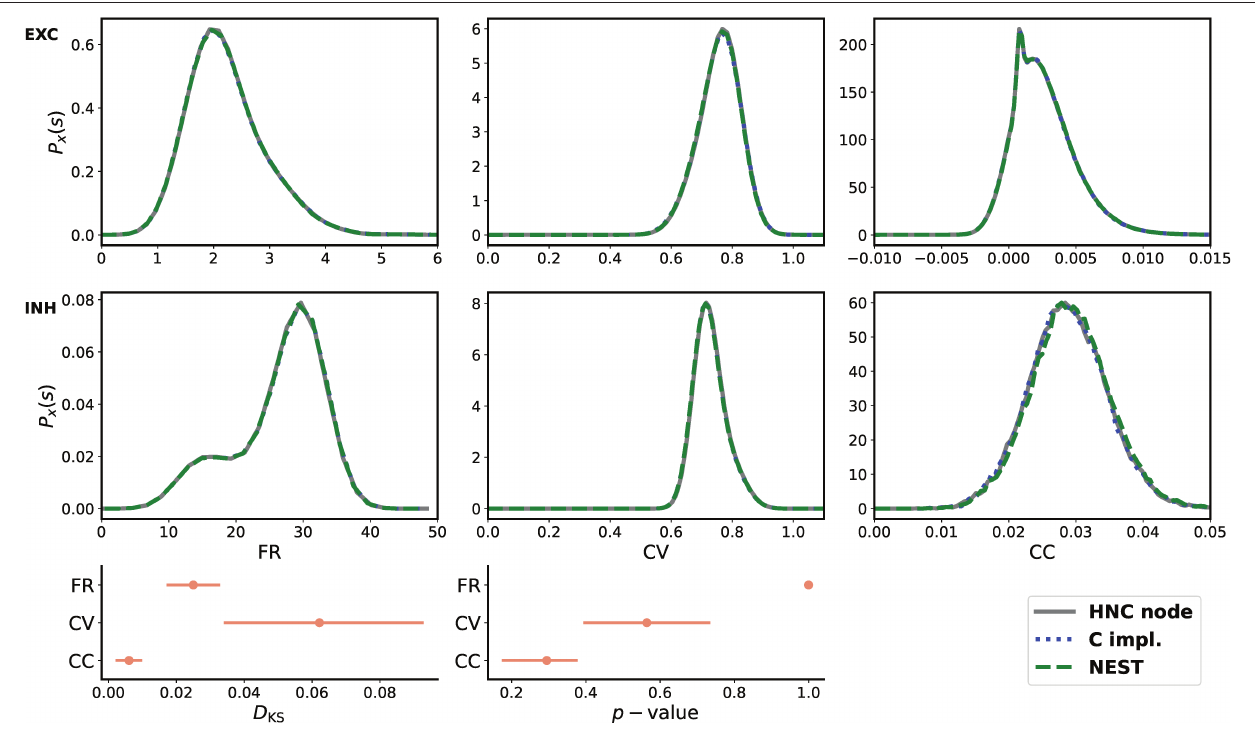
FIGURE 5 | Quantitative comparison of statistical measures. Upper two rows from left to right: probability distribution of average firing rate (FR), coefficient of variation (CV), and Pearson’s correlation coefficient (CC) for the excitatory (EXC) and the inhibitory (INH) population. The measures were calculated from 30 min simulated time. For the calculation of CC, spike trains were binned at 2 ms. In order to derive the probability distributions from the calculated measures, the Freedman-Diaconis rule was applied to select the width of the bins of the distribution histograms, and a Gaussian kernel was used for density smoothing. The bottom row shows the Kolmogorov-Smirnov statistics calculated from the raw samples of the calculated statistical measures. During the simulations performed on the HNC node, using the NEST simulator, and carried out using the reference C implementation, the network was stimulated with a different random input—a limitation of the HNC node prototype and hardware implementation of the PRNG. All three simulations used the same explicit Forward Euler integration method with an integration step size of h = 0.1 ms. All measures are in close agreement and show statistical